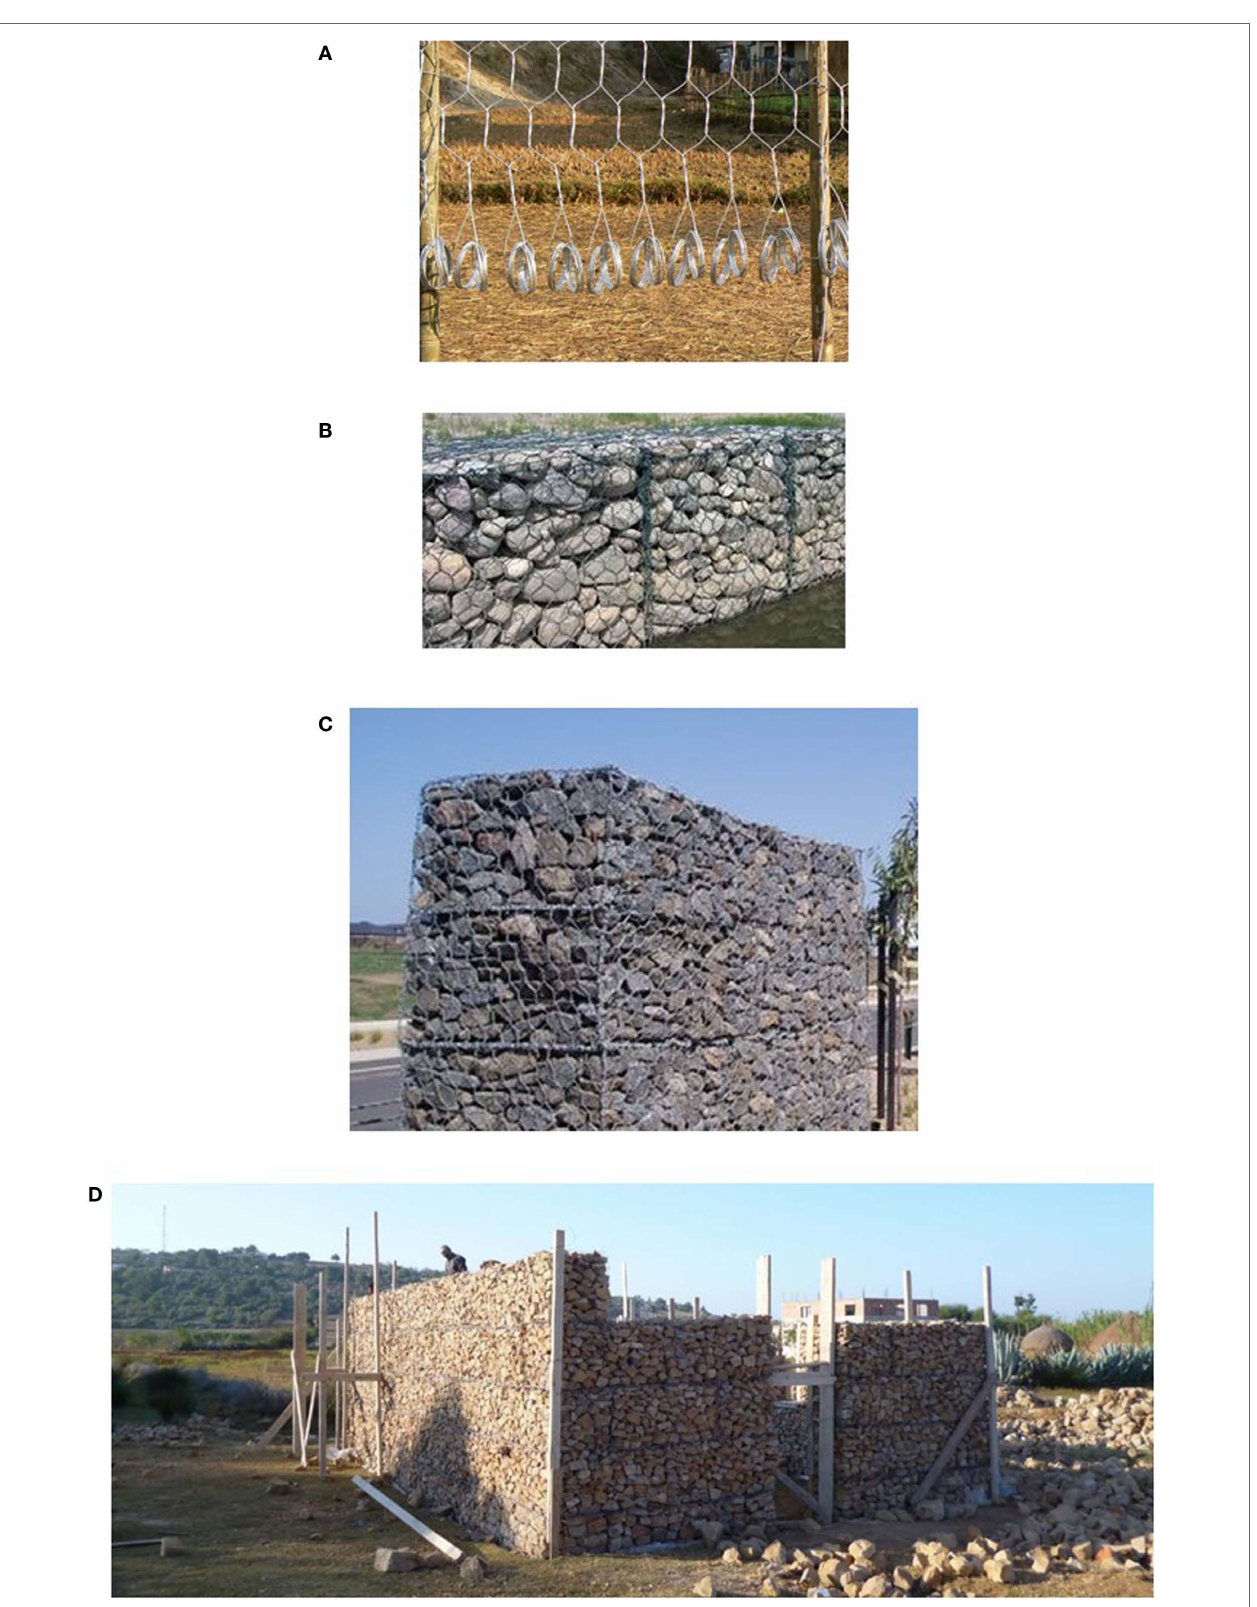
FIGURE 2 | (A) The typical wire mesh. (B) The gabion-box. (C) The gabion-box wall (courtesy from Anping Xingmao Metal Wire Mesh Co., Ltd. ). (D) The gabion-box walls building (courtesy from A&D—Architecture and Development —www.archidev.com working with architecture sans frontiers Nepal ).